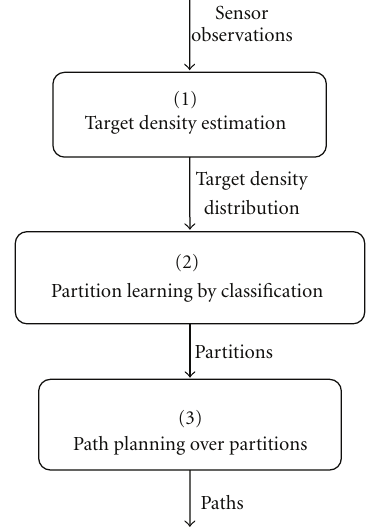
Figure 1: Problem structure of new approach for autonomous search and tracking. The problem is decomposed into three steps. Each of these steps is performed at each instance in time. As the target estimation changes with time, so do the partitions and the agent paths.